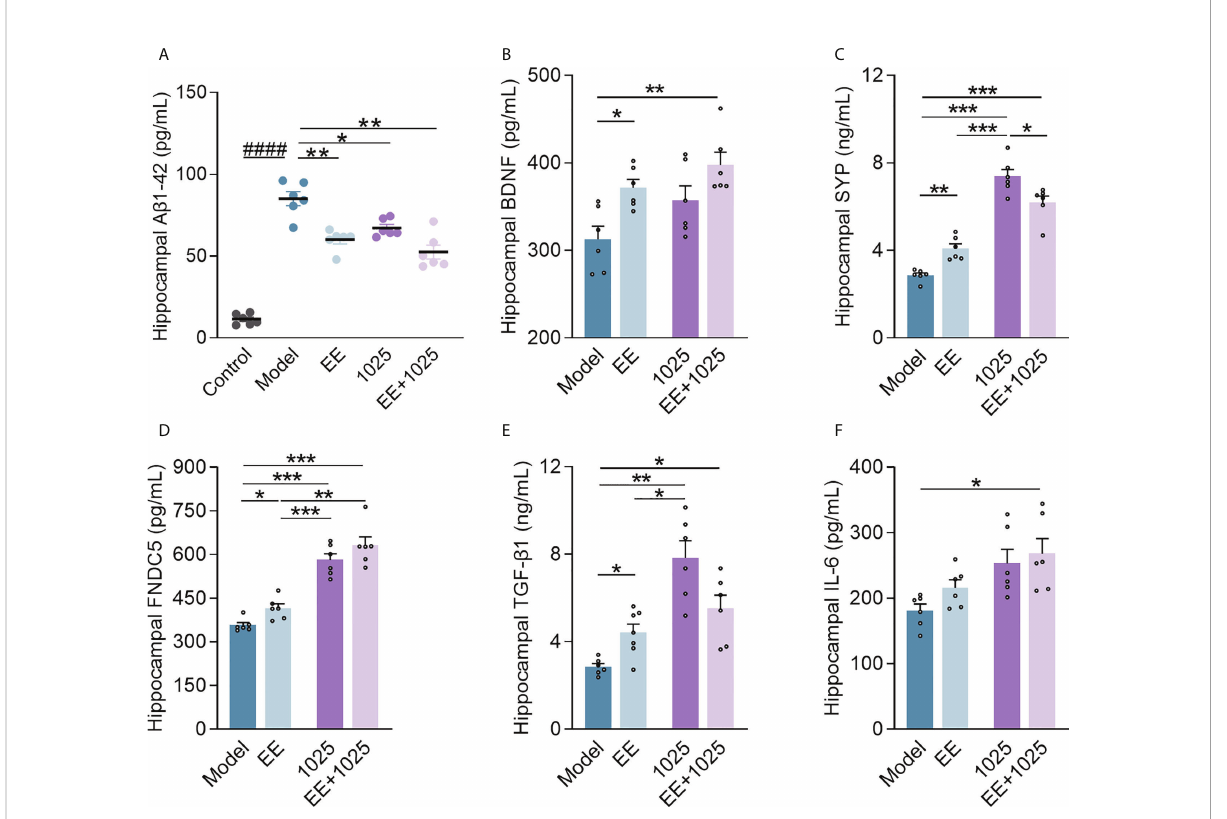
FIGURE 3 EE combined with B . breve CCFM1025 treatment inhibits AD-related neuroin fl ammation and synaptic impairments in the brain. (A) Hippocampal A b 1-42 levels (n = 6 – 8). (B) Hippocampal BDNF levels (n = 6 – 8). (C) Hippocampal SYP levels (n = 6 – 8). (D) Hippocampal FNDC5 levels (n = 6 – 8). (E) Hippocampal TGF- b 1 levels (n = 6 – 8). (F) Hippocampal IL-6 levels (n = 6 – 8). Data are presented as mean ± standard error of the mean (mean ± SEM). Each data point represents one independent mouse. Control vs. Model: #### P < 0.0001 by unpaired student ’ s t-test; * P < 0.05, ** P < 0.01, *** P < 0.001 as determined by one-way